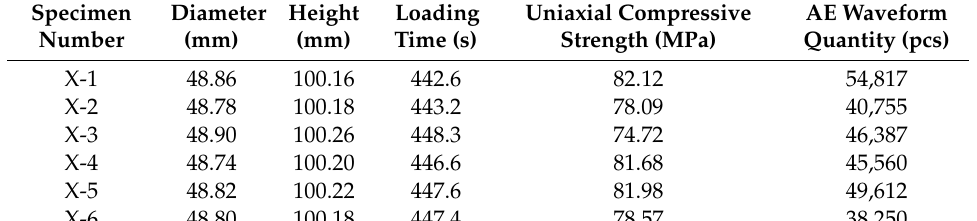
Table 1. Comparison basic physical and mechanical parameters of specimens.